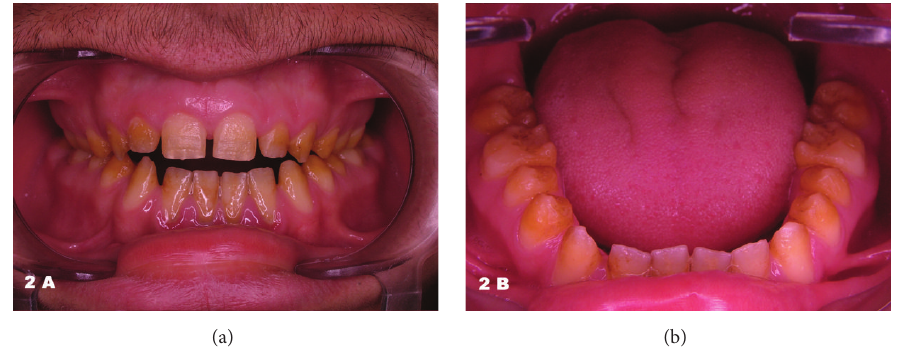
Figure 2: Intraoral frontal view of the patient (a) and occlusal surfaces of the mandibular arch (b) before treatment.